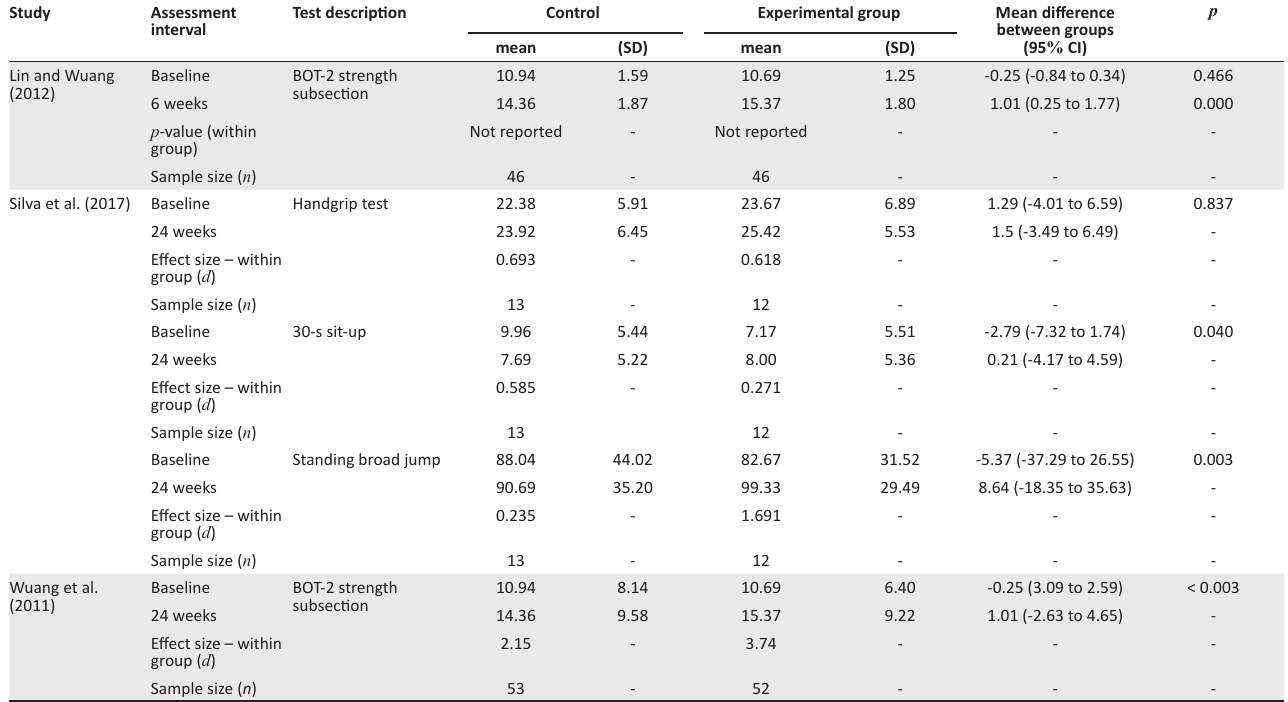
TABLE 6 : Results reported for strength measures of included studies. Study